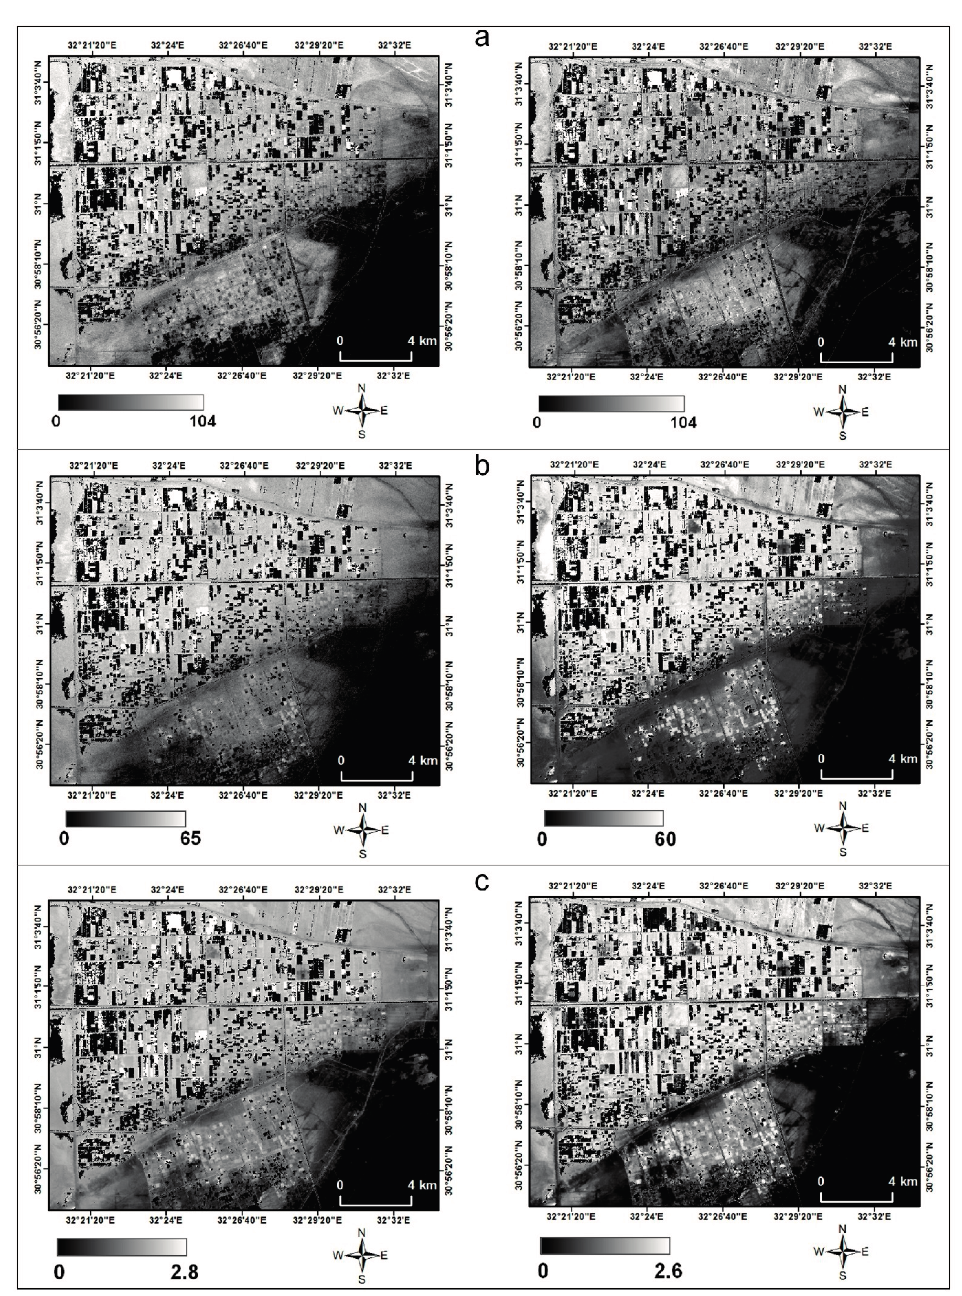
Figure 6. Quantitative maps of ( a ) EC e , ( b ) clay content and ( c ) OM based on the PLSR ( left ) and MARS ( right )